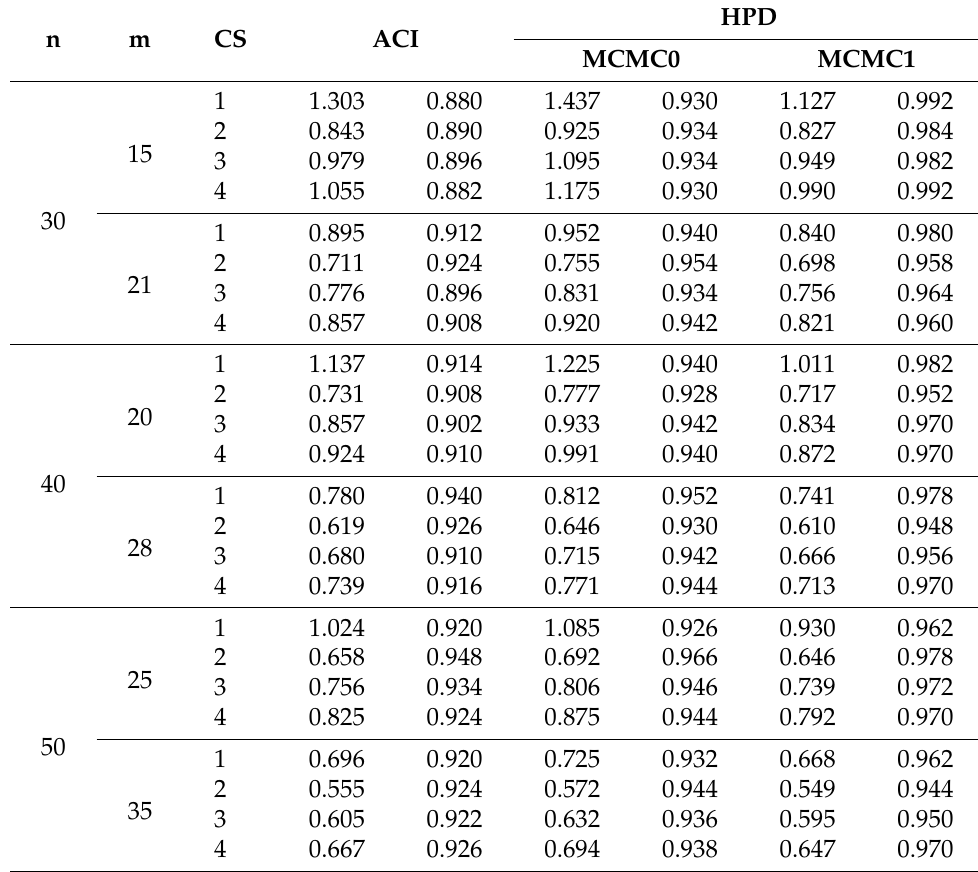
Figure 2. Posterior risks of estimators of entropy under different β ( α = 0.5). Table 5. Average widths (AWs) (first column) and CVs (second column) of 95% confidence/credible intervals of entropy estimates for Burr XII distribution with α = 3 and β = 2 under different censoring schemes ( γ =